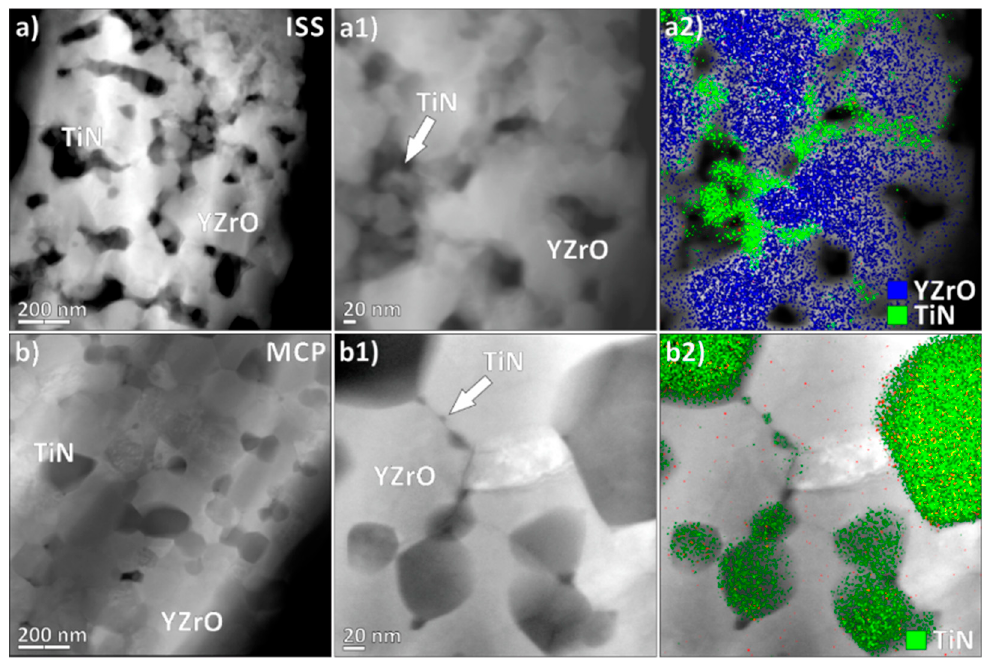
Figure 4. HAADF-STEM micrographs of sintered ( a , a1 ) ISS and ( b , b1 ) MCP ZrO 2 –TiN ceramic, with corresponding EDS overlay maps ( a2 , b2 ) of Zr L and Ti K, interpreted as Y-TZP and TiN, respectively.